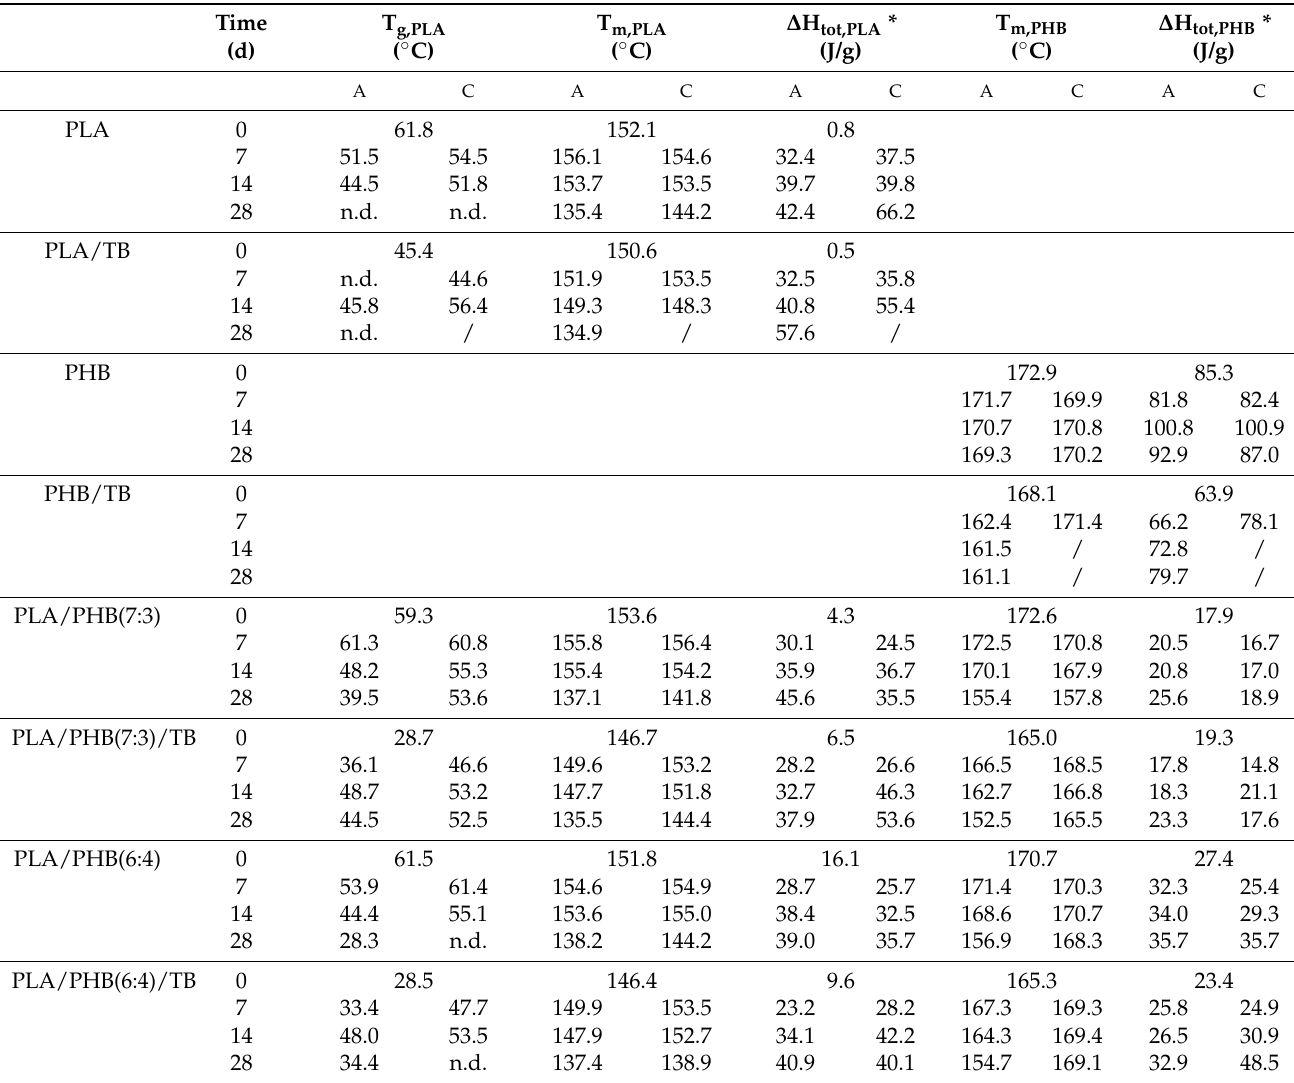
Table 5. Thermal properties obtained during the first DSC scan of annealed (A) and composted (C) films of neat and plasticized PLA, PHB, and PLA/PHB blends at different test times. (n.d.: not detected; for these samples, T g could not be detected in the DSC